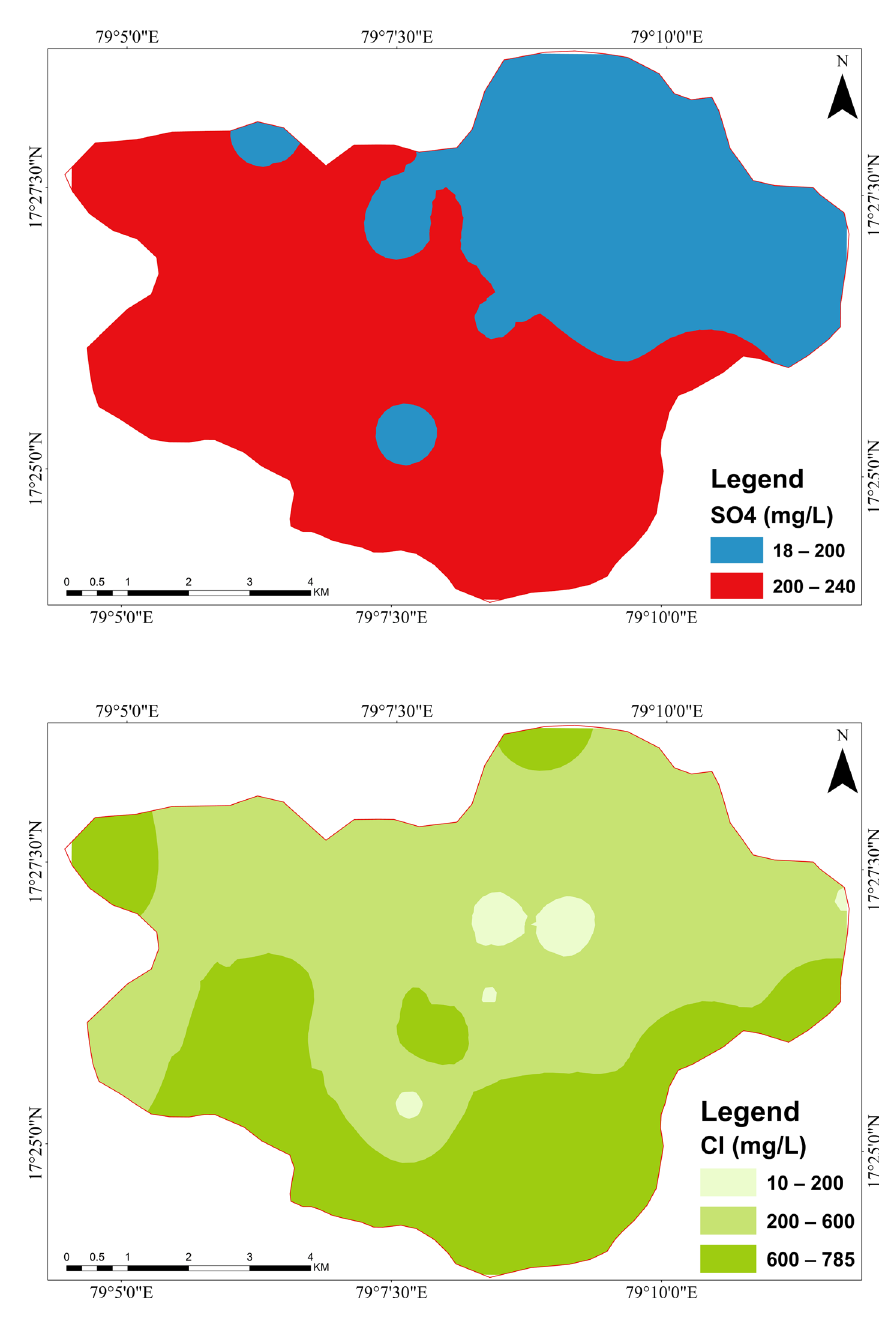
Fig. 11 Spatial distribution map